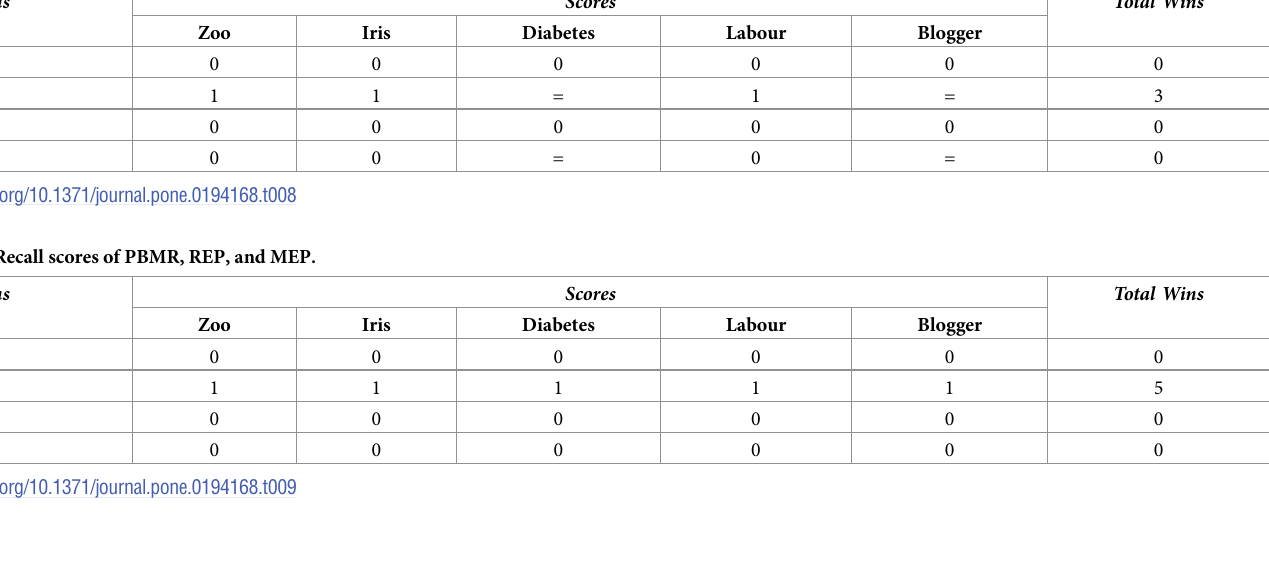
Table 8. Precision scores of PBMR, REP, and MEP. Algorithms